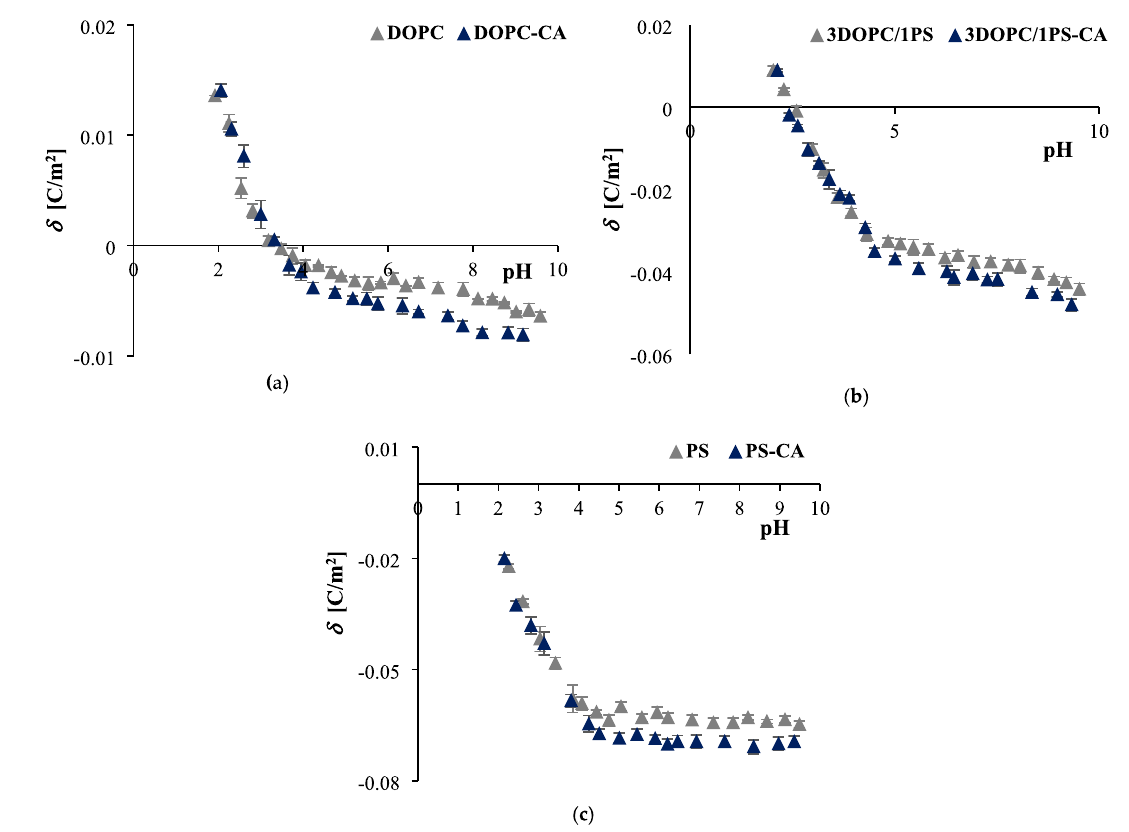
Figure 3. pH-dependent surface charge density curves of ( a ) DOPC, ( b ) 3DOPC/1PS, ( c ) PS liposomal membranes as a function of 0 (grey), and 1 mmol/L (navy blue) concentration of caffeic acid.